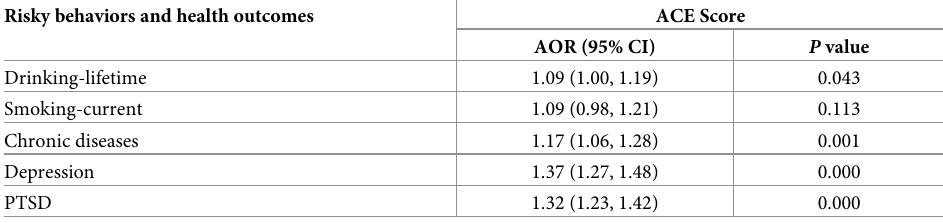
Table 3. Multivariate logistic regression models for relationship between ACE score and risky behaviors and health